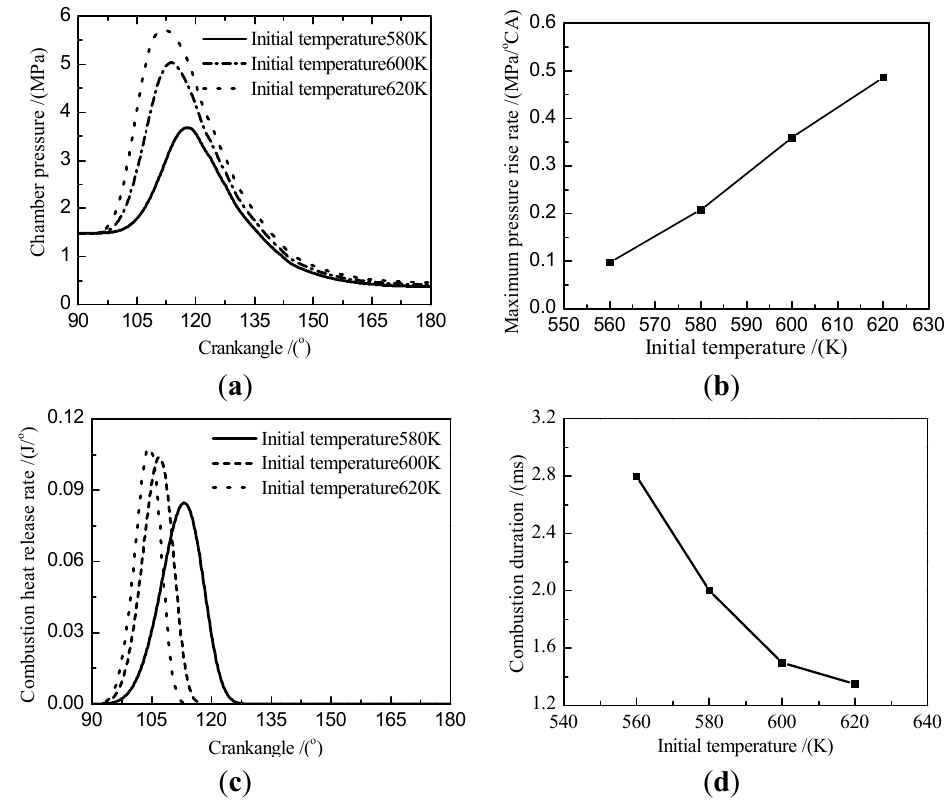
Figure 12. ( a ) Chamber pressure for initial temperature; ( b ) Maximum pressure rise rate for initial temperature; ( c ) Combustion heat release rate for initial temperature; ( d ) Combustion duration for different initial temperature.